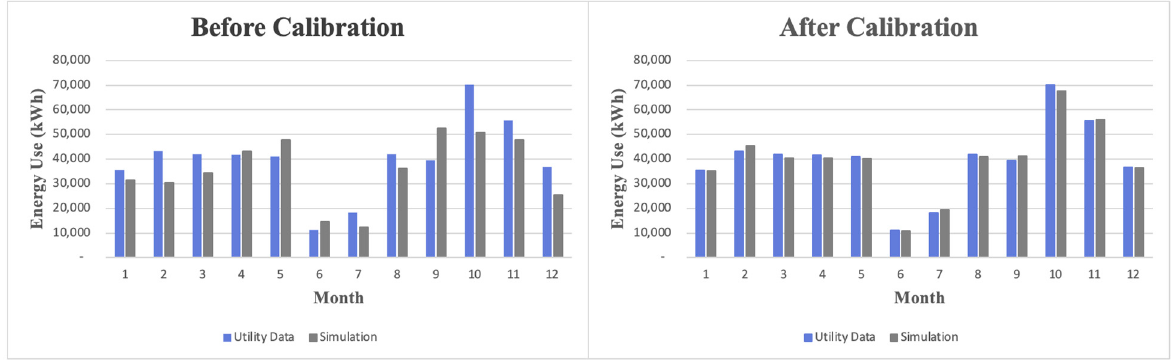
Figure 1. 3 ‐ D renderings of the prototypical school building energy model including a fl oorplan layout developed using DesignBuilder.